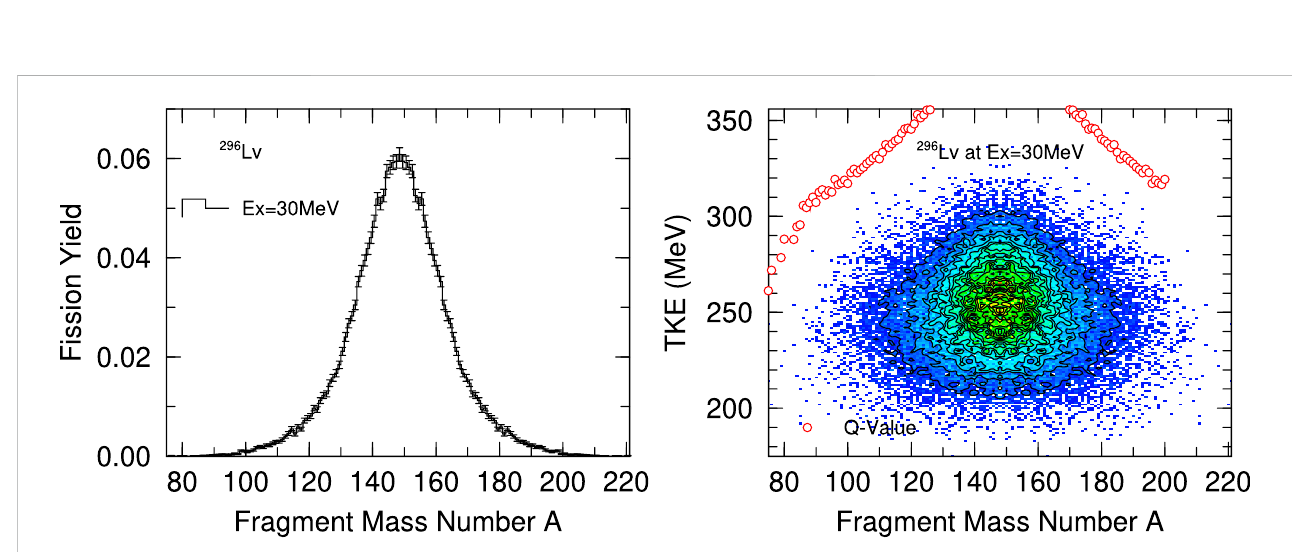
FIGURE 8 TKEs and FFMD of nuclear fi ssion of 296 Lv at Ex = 30 MeV. (Right panel) TKE distribution color map calculated by the Langevin model with the Q-values. (Left panel) Fission fragment mass distribution as a function of fi ssion fragment mass